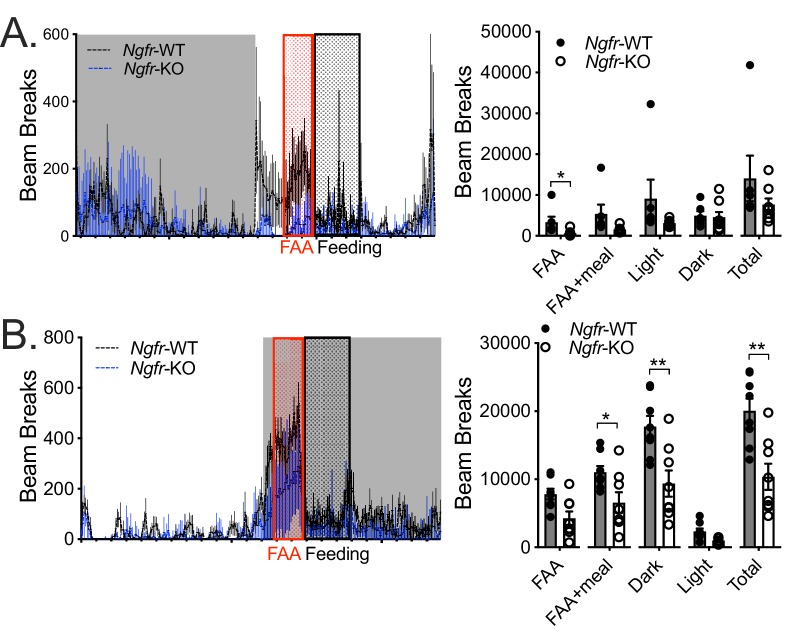
Daytime restricted feeding selectively dampens FAA, while nighttime restricted feeding blunts several activity measures.(A) 24 hr plot of day five restriction locomotor activity (left) quantified into several discrete time periods (right); n = 6/group. *p=0.046 by Student’s t-test. (B) 24 hr plot of night five restriction locomotor activity (left) quantified into several discrete time periods (right); n = 8/group. All mice are age and weight-matched. Gray shaded areas correspond to the dark cycle. Data are presented as mean ± SEM. *p=0.0214, **p<0.0001 by Student’s t-test.